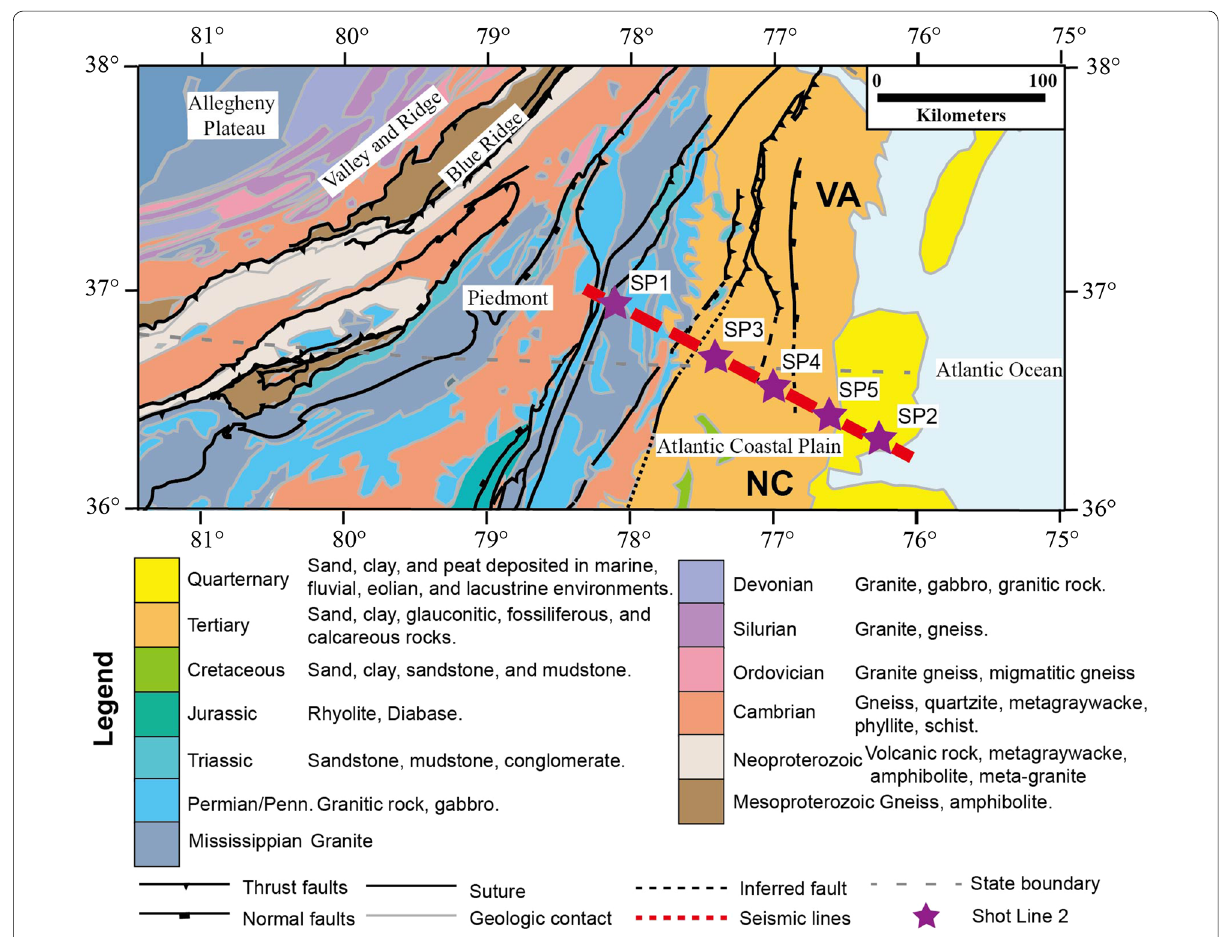
Fig. 2 The geologic map of study area based on the maps by King and Beikman (1974) and Glover and Klitgord (1995). This map shows the tectonic setting and lithologies in the study area, from Atlantic Ocean to the Appalachian